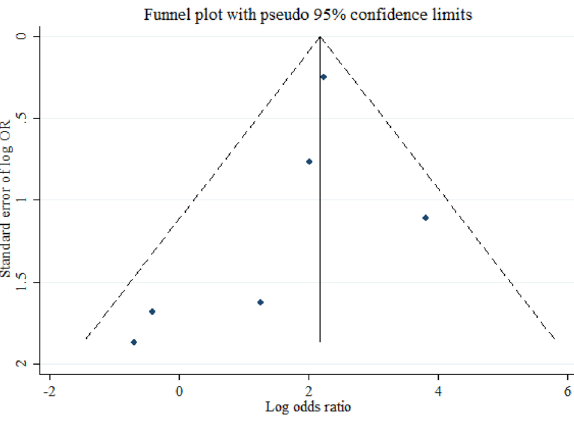
Figure 7. The Deeks’ funnel plot curve for assessment of publication bias.